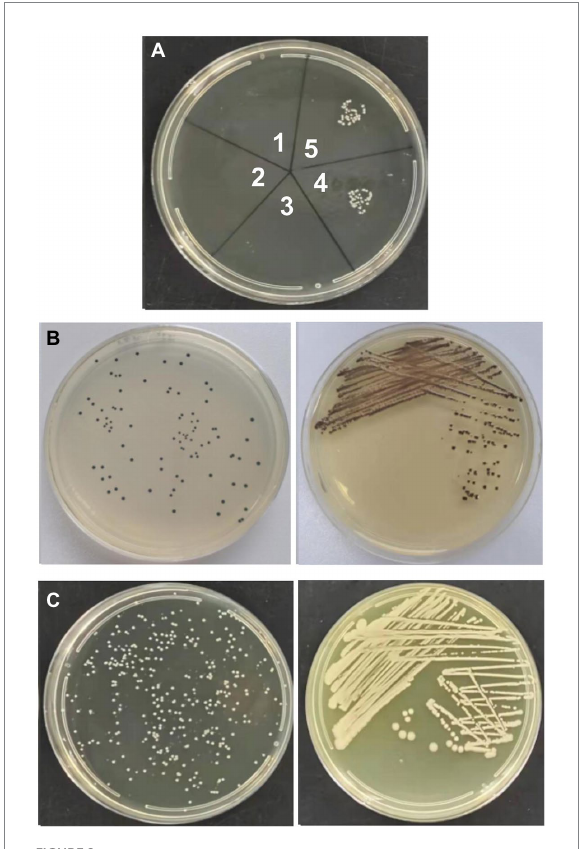
FIGURE 2 Vesicle-mediated transformation. (A) transformants in LB plate with 2 mg/l imipenem and 5 mg/l potassium tellurite. Note: 1. 20ug of CR-HvKP-OMVs previously lysed with Triton X-100; 2. 50ug of CR-HvKP-OMVs previously lysed with Triton X-100; 3. the free plasmid of NUHL30457; 4. 20ug of CR-HvKP-OMVs treated with DNase I and proteinase K; 5. 50ug of CR-HvKP- OMVs treated with DNase I and proteinase K. (B) transformants in LB plate with 5 mg/l potassium Tellurite. (C) transformants in LB plate with 2 mg/l